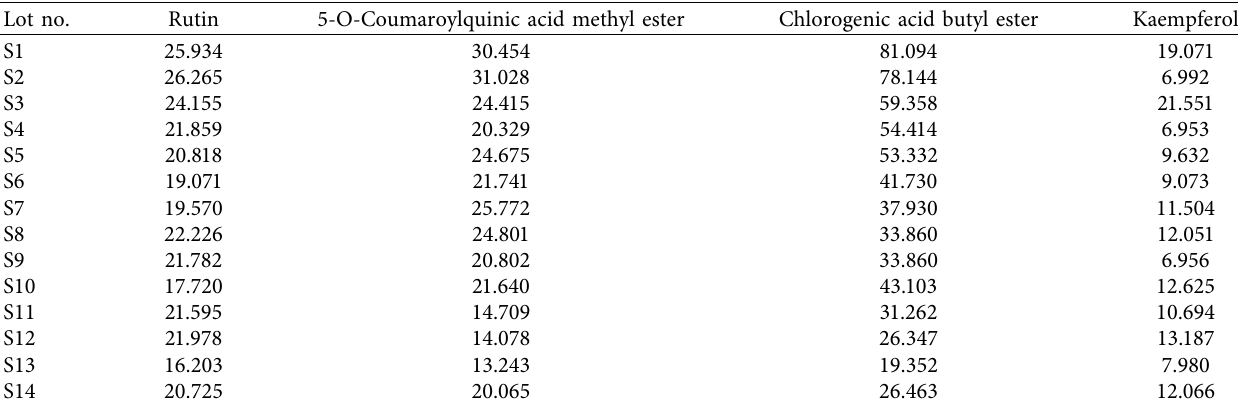
Table 4: The content of four active ingredients of samples ( n � 3, μ